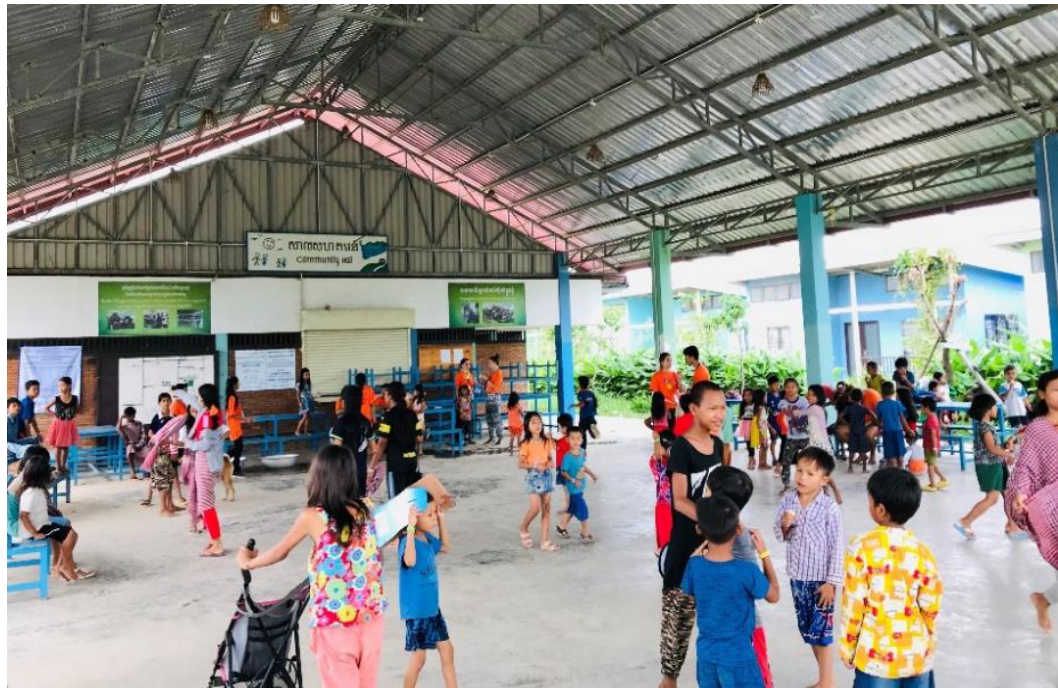
Figure 7. Children gathering and playing in the community center. Source: Author.